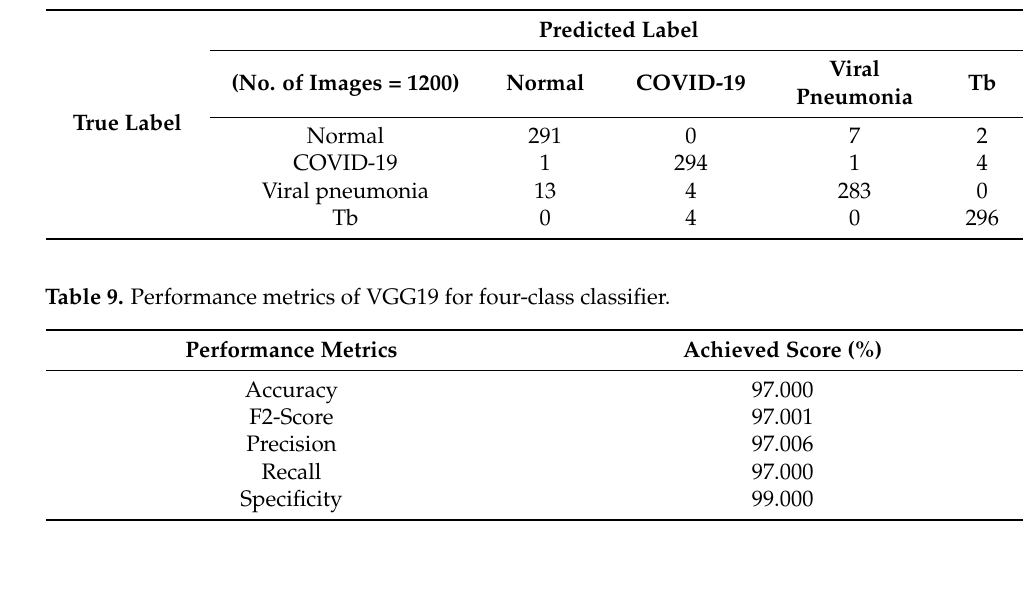
Figure 4. Accuracy ( left ) and loss curves ( right ) of DenseNet201 for three-class classifier. Table 8. Validation confusion matrix of VGG19 for four-class classifier.